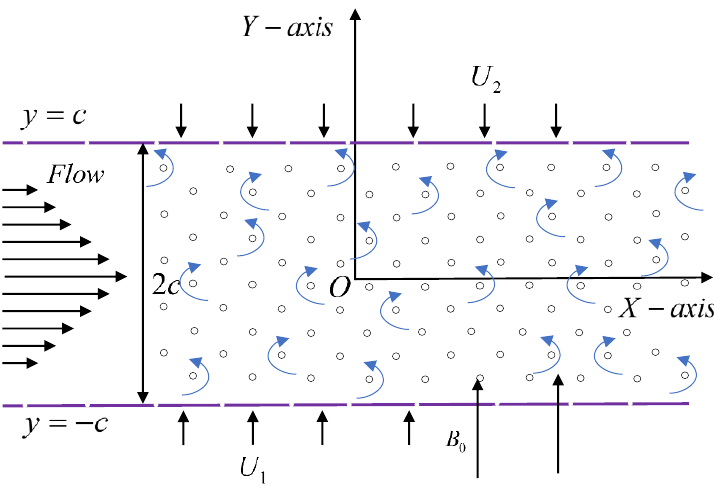
Figure 1. Porous channel